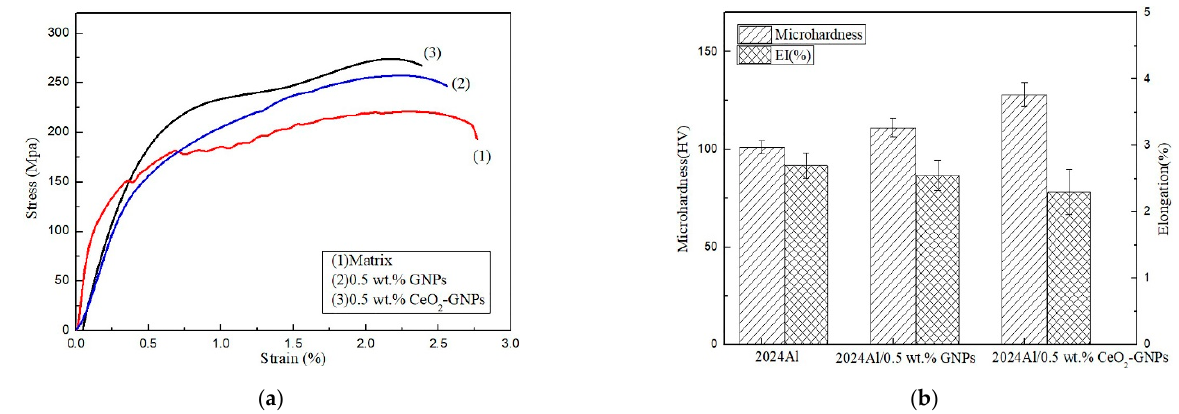
Figure 8. Tensile strain-stress curves (a) and microhardness (b) of the composites fabricated and 2024 Al alloy matrix. Table 2. Corresponding mechanical properties of composites prepared.